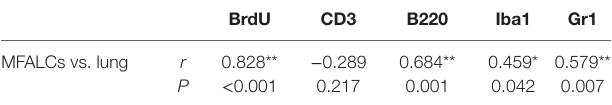
*Significant, P < 0.05. **Highly significant, P <